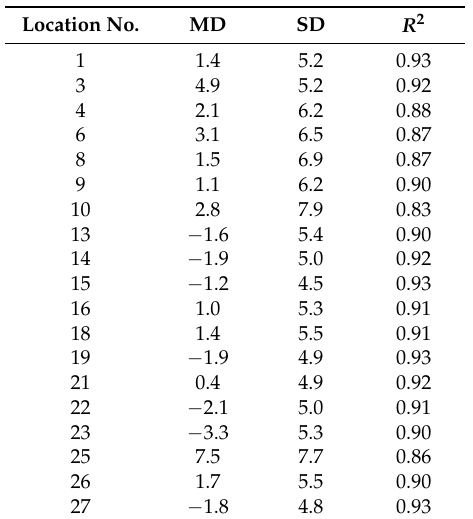
Table 3. Mean difference (MD), standard deviation (SD), and linear regression correlation ( R 2 ) between the measured T air and LST using all dates of Landsat image acquisition.